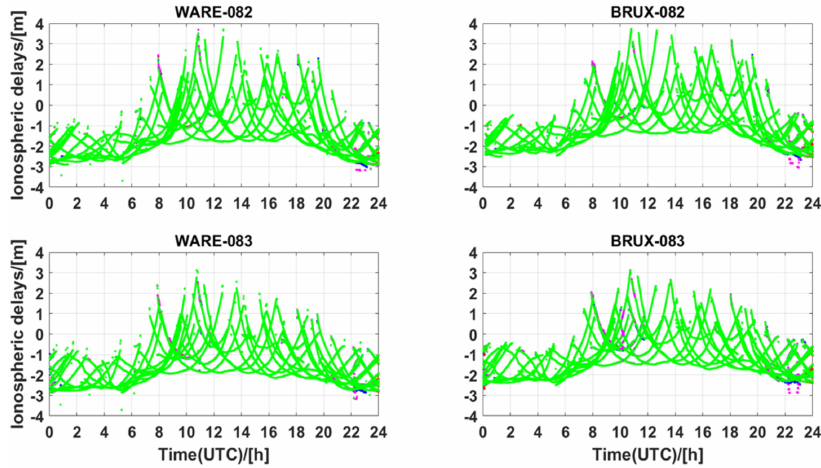
Figure 11. Interpolated slant ionospheric delays of WARE and BRUX stations derived from the reference stations on DOY 082, 083, 2021. The four groups of UCPPP PAR solutions—F2-MAX, F2-ALT, F3-MAX, and F3-ALT—are plotted as solid red, blue, pink, and green circles, respectively.